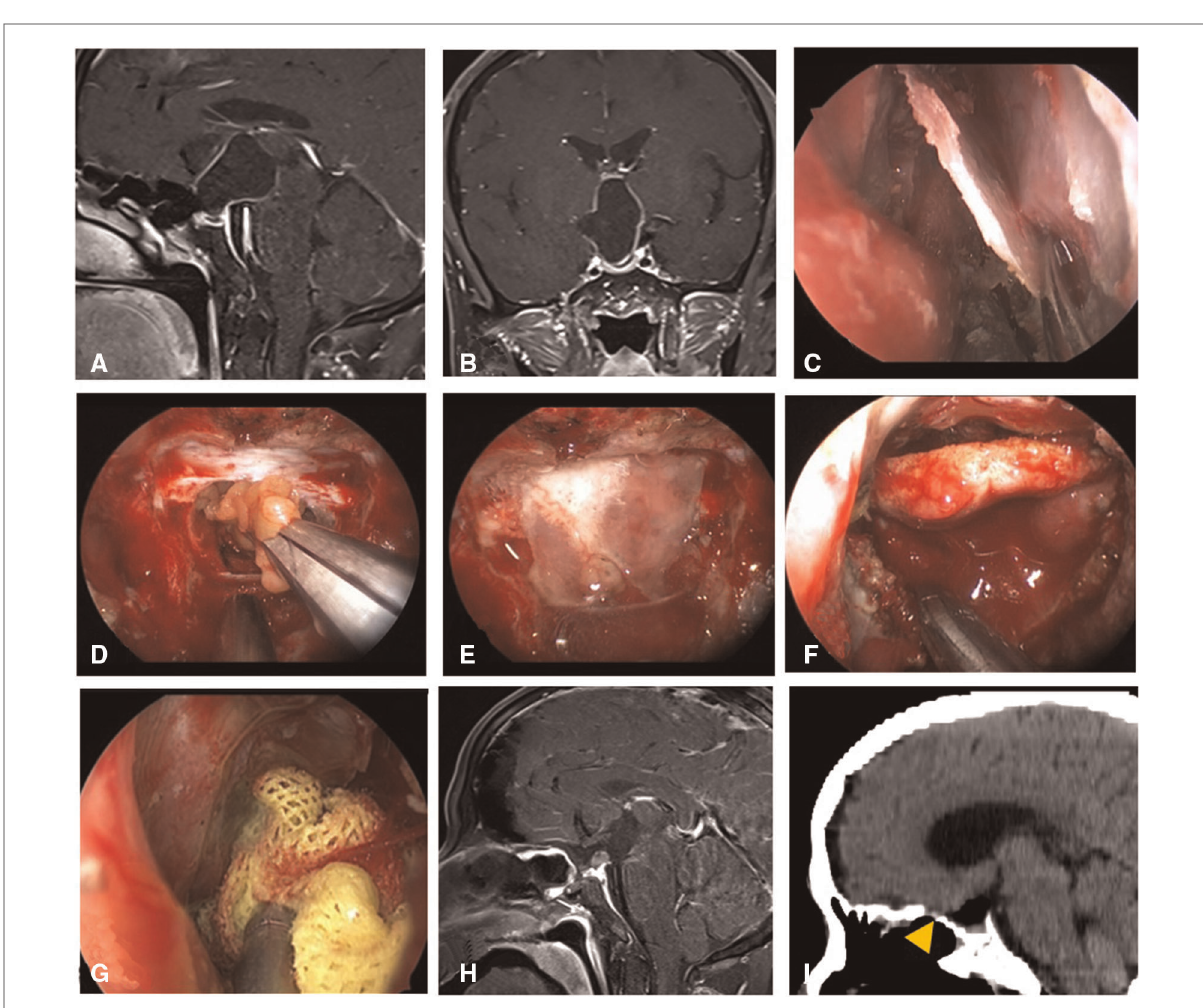
FIGURE 4 Changes in reconstruction strategy/(after) [( C ) harvest of nasal septum bone fl ap; ( D – G) process of reconstruction]. ( A,B ) MRI enhanced in sellar region before operation, and craniopharyngioma was considered before operation. ( C ) Separation of nasal septum bone fl ap. ( D ) Subdural fat packing. ( E ) Repair of skull base bone window with trimmed nasal septum bone fl ap. ( F ) Cover the VP-NSF on the nasal septum bone fl ap. ( G ) Gauze support. ( H ) MRI enhanced in sellar after operation and postoperative pathology showed craniopharyngioma. ( I ) CT bone window showing nasal septum bone fl ap was in place. VP-NSF, vascularized pedicle nasoseptal fl ap.